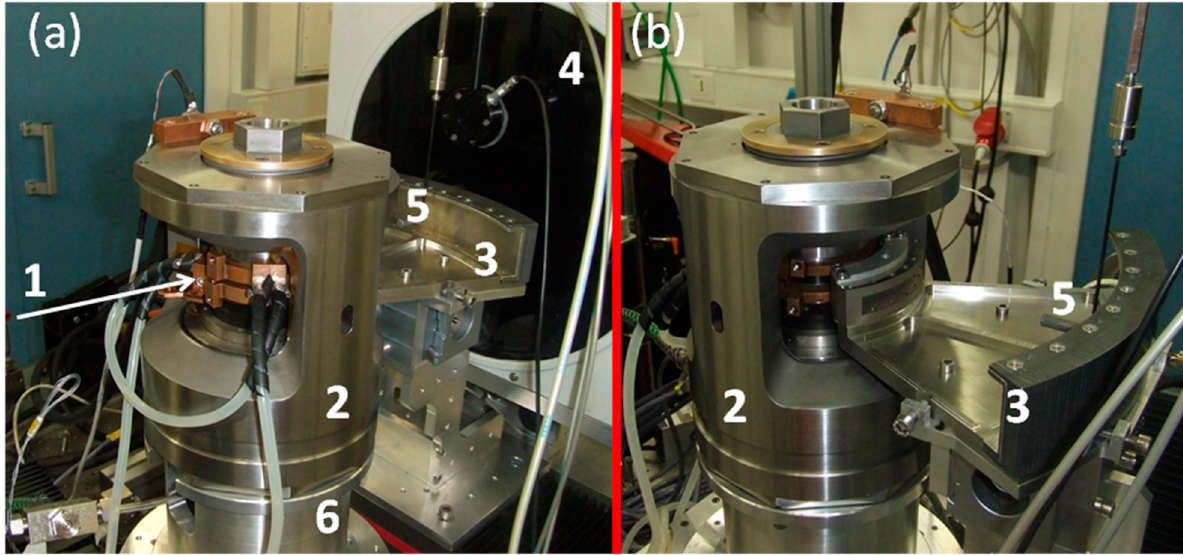
Figure 6. Front ( a ) and rear ( b ) views of the Paris–Edinburgh press installed on the ID27 beamline of ESRF. (1) Incoming beam. (2) Paris–Edinburgh press. (3) Sollers slits system. (4) Image-plate detector. (5) Motorized beamstop. (6) Press-positioning x-y-z motors.